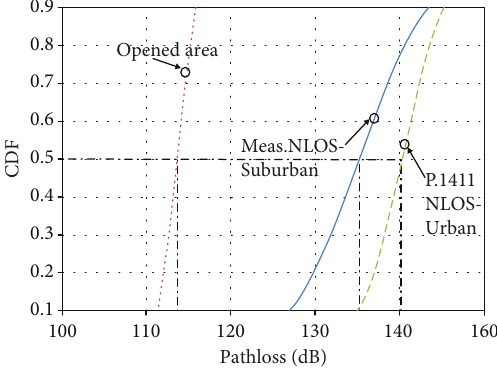
Figure 16: CDF in NLoS environment (at